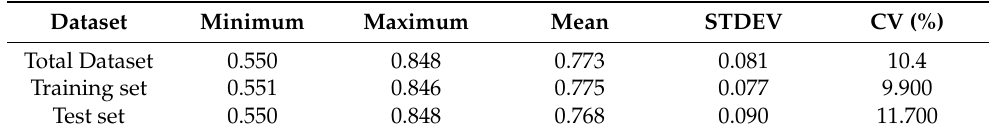
Table 6. Basic statistics of the measured